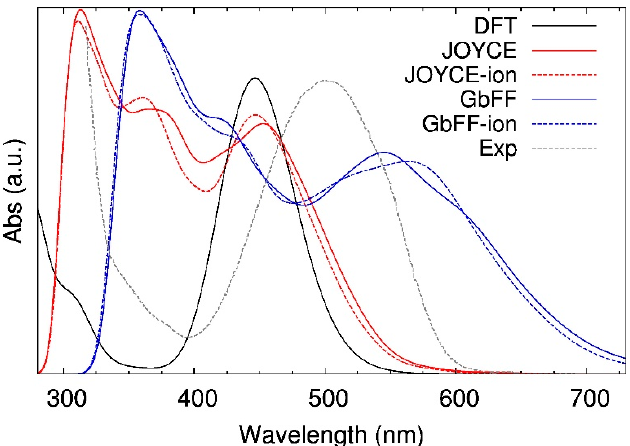
Figure 7. Calculated thermalized absorption spectra obtained for MD runs performed with J oyce (red) and GbFF (blue) methods, when employing solvent (continuous) and solvent+ion (dashed lines) QM/MM layers; together with the reference static DFT (black) and experimental (dashed grey line) spectra, which has been adapted from reference [37]. All vertical excitations have been computed at the TD-B3LYP*/6-311G* level of theory.